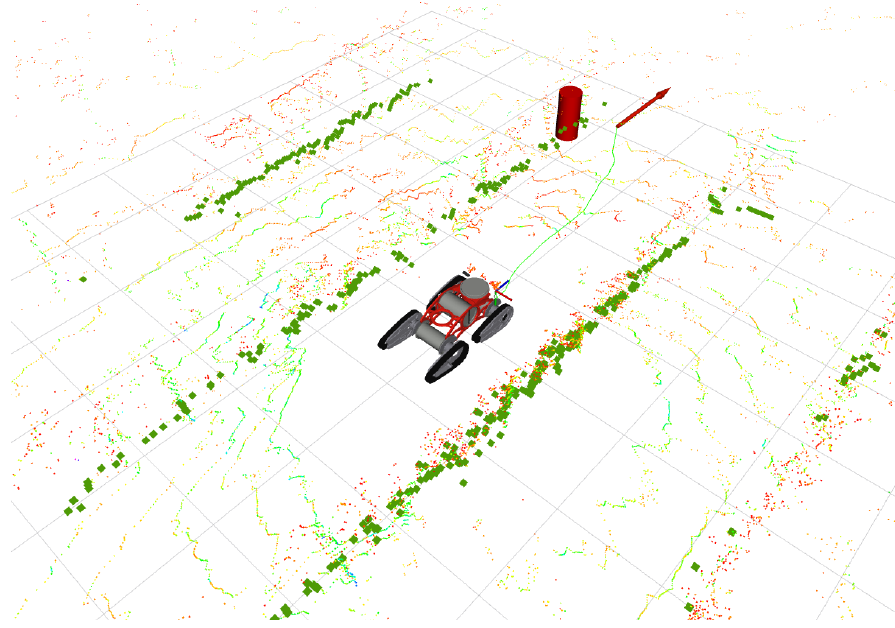
Figure 16. An experimental setup for autonomous navigation to the recognized vine in a vineyard environment, visualized in Rviz. This visualization uses data that has been acquired during the experimental campaign in Jazbina vineyard. The robot’s perception of the environment at the beginning of the experiment is shown. The position of the detected vine is marked with the red cylinder. The red arrow is the goal pose of the robot. The goal pose is located in the immediate vicinity of the detected vine. In the goal pose, the distance between the vine and the robot d vp should be smaller than d op